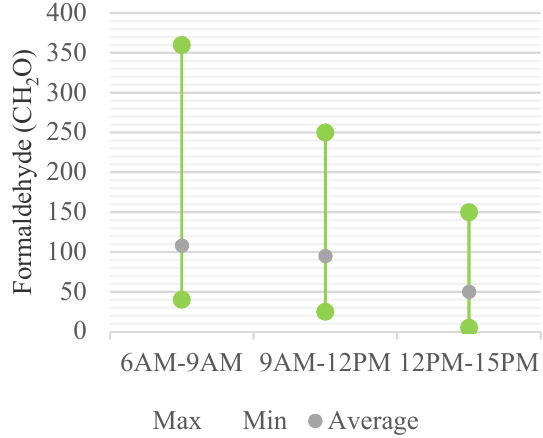
Figure 10. Daily Concentration Change of CH 2 O.